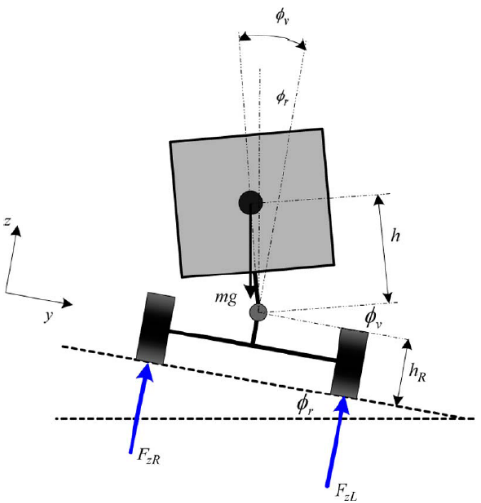
Figure 1. Planar model of vehicle dynamics.